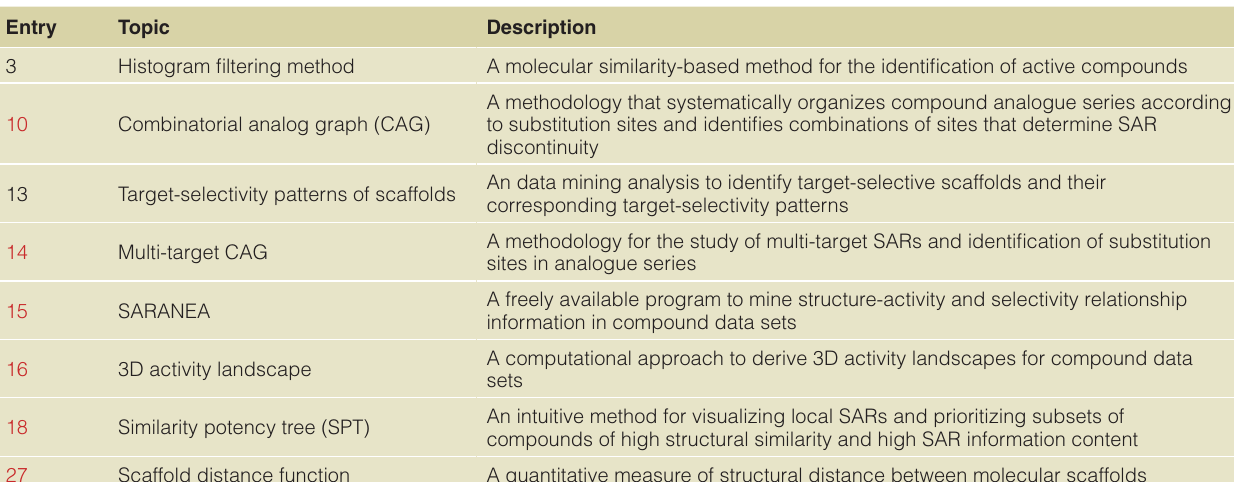
Table 2. Description of programs and methods. Eight entries with methods/programs are listed. For each entry, a brief description is provided. Selected entries are highlighted in red and discussed in the text. Entry